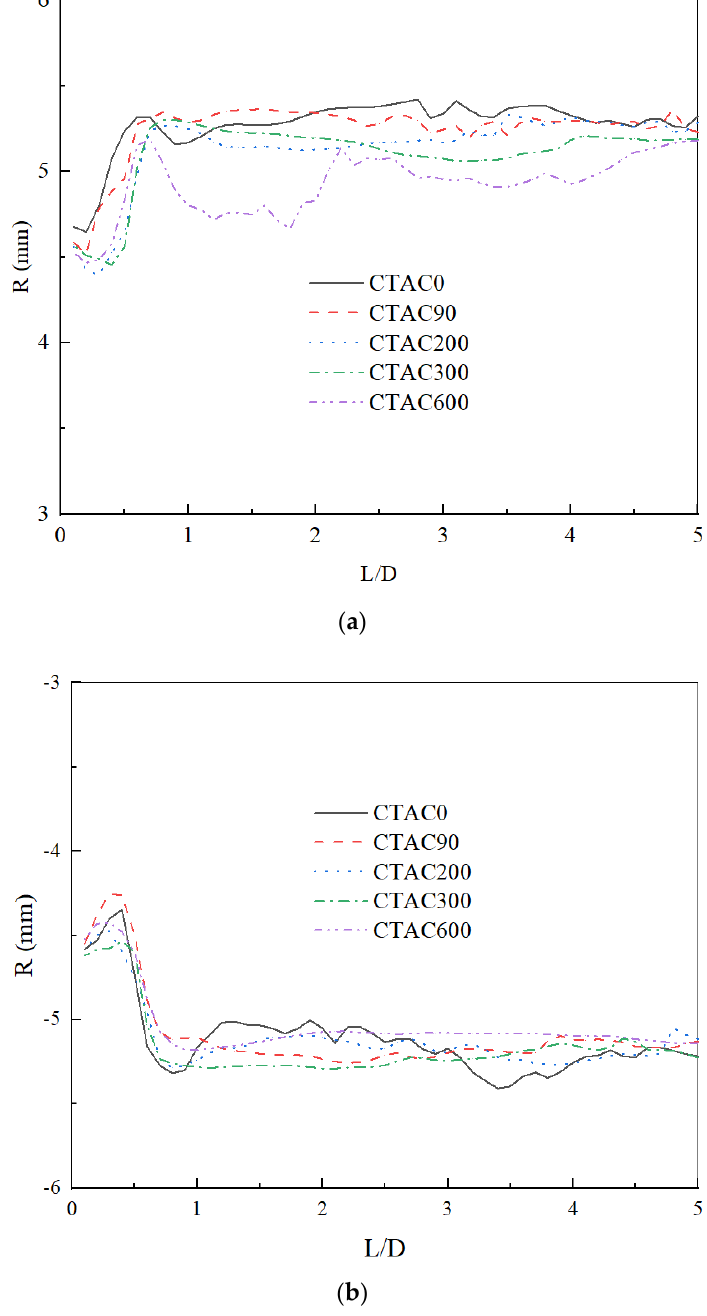
Figure 14. The interface at the sudden-contraction pipe downstream. ( a ) top interface; ( b ) bottom